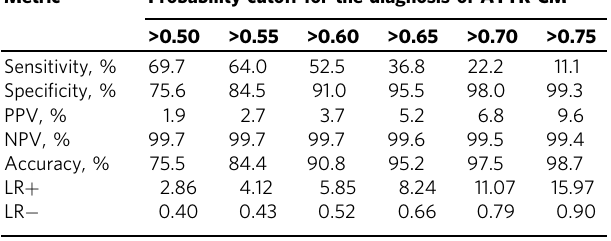
Table 3 Prediction of cardiac amyloidosis in the Northwestern Medicine Enterprise Data Warehouse Heart Failure Cohort using the wild-type ATTR-CM Random Forest prediction model.